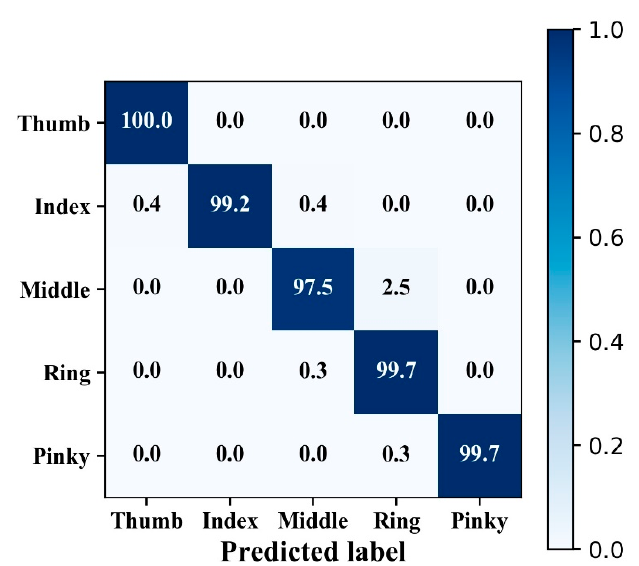
Figure 4. Confusion matrix of hand gesture classification from a typical subject (subject 10). The overall classification accuracy for this trial was 99.2%.